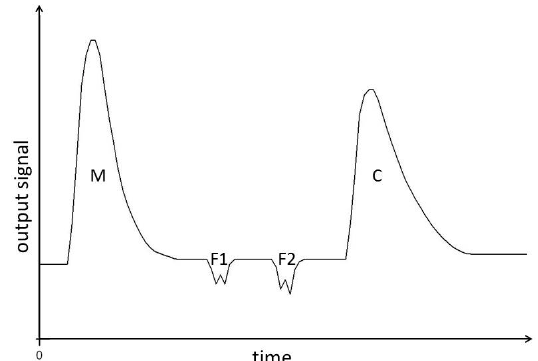
Figure 2. Example of an output signal from a batch calorimeter: peak designated by M represents the heat effect due to dilution of aqueous iPMA solution with water by a factor of 2 ( T = 25 °C), peak C corresponds to calibration and peaks F1 and F2 are heat effects due to shearing of solutions in the calorimeter (see text).